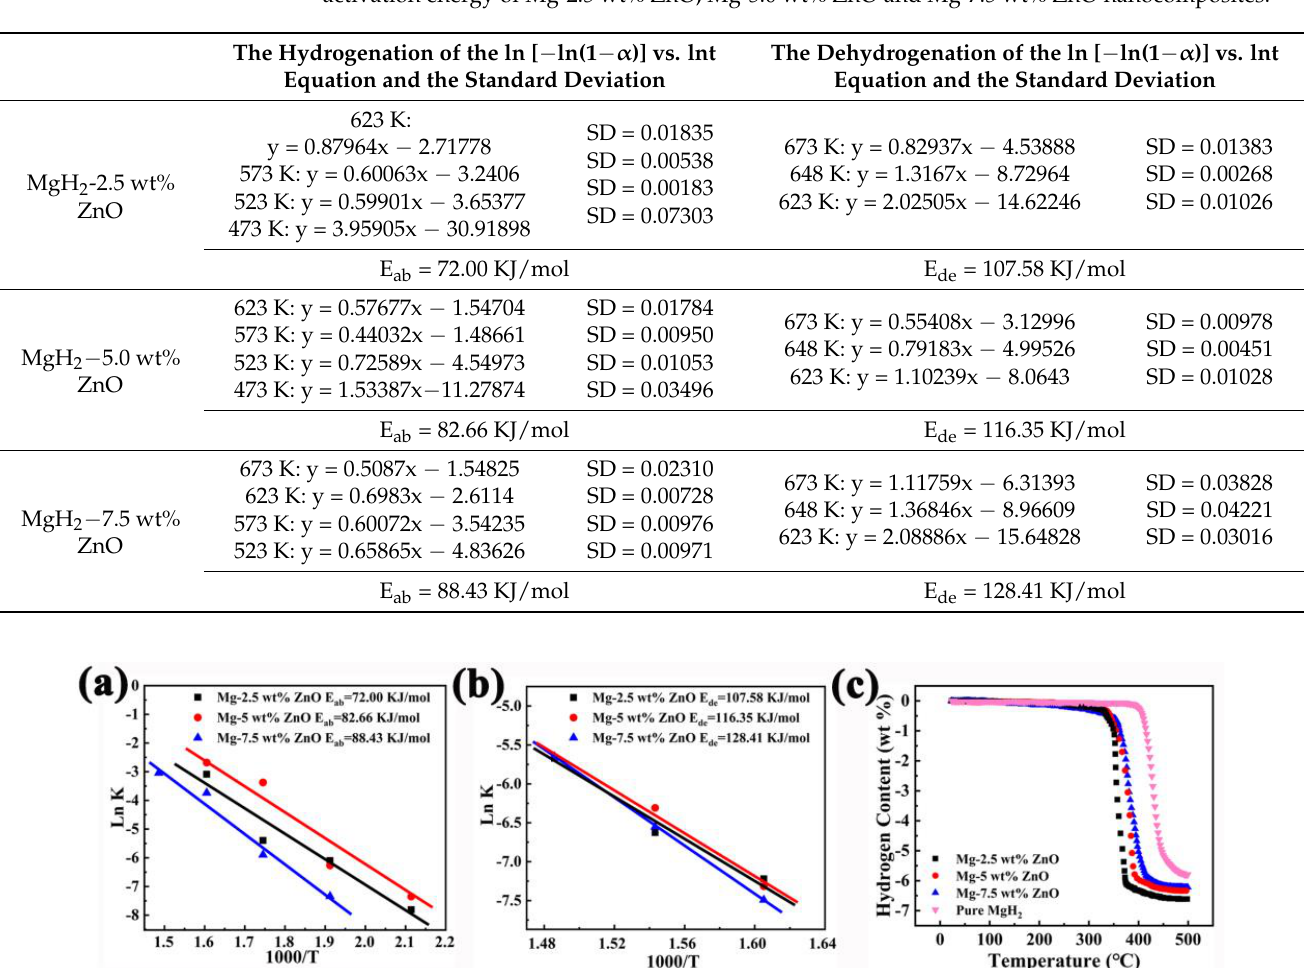
Table 1. The hydrogenation of the ln [ − ln(1 − α )] vs. lnt equation, the standard deviation and